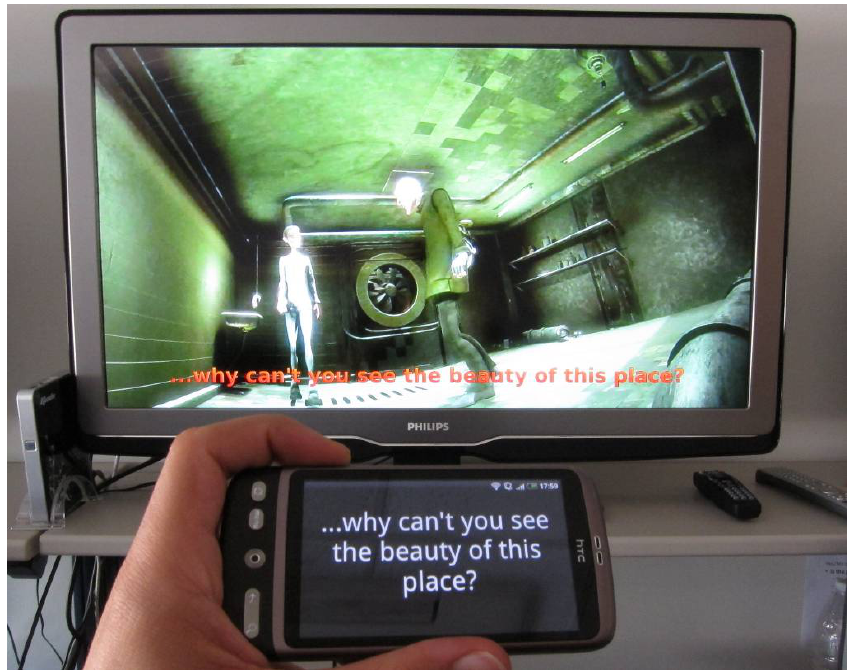
Figure 10. An example of a second screen application for receiving subtitles on an Android 2.2